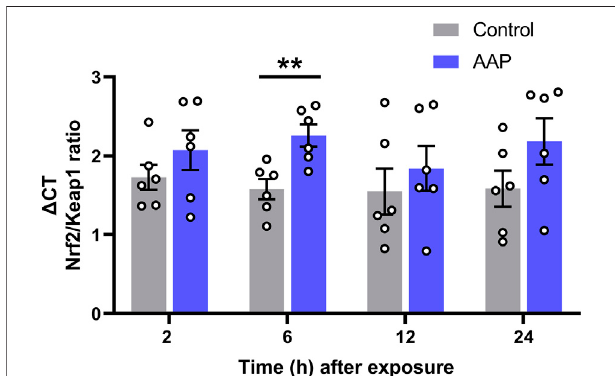
FIGURE 2 | Transcript level ratios of the genes Nrf2 and Keap1 2, 6, 12, and 24 h after exposure to vehicle or AAP (30 + 30 mg/kg, 4 h apart) on PND 10. Δ CT in Nrf2/Keap1 expression ratio is relative to that ofthe corresponding untreated mice at each time point (not shown). Statistics were done on the raw data ( Δ CT) at each time point. **, p < 0.005 (by Student ’ s t test). Bars represent means ± SEM of six mice.